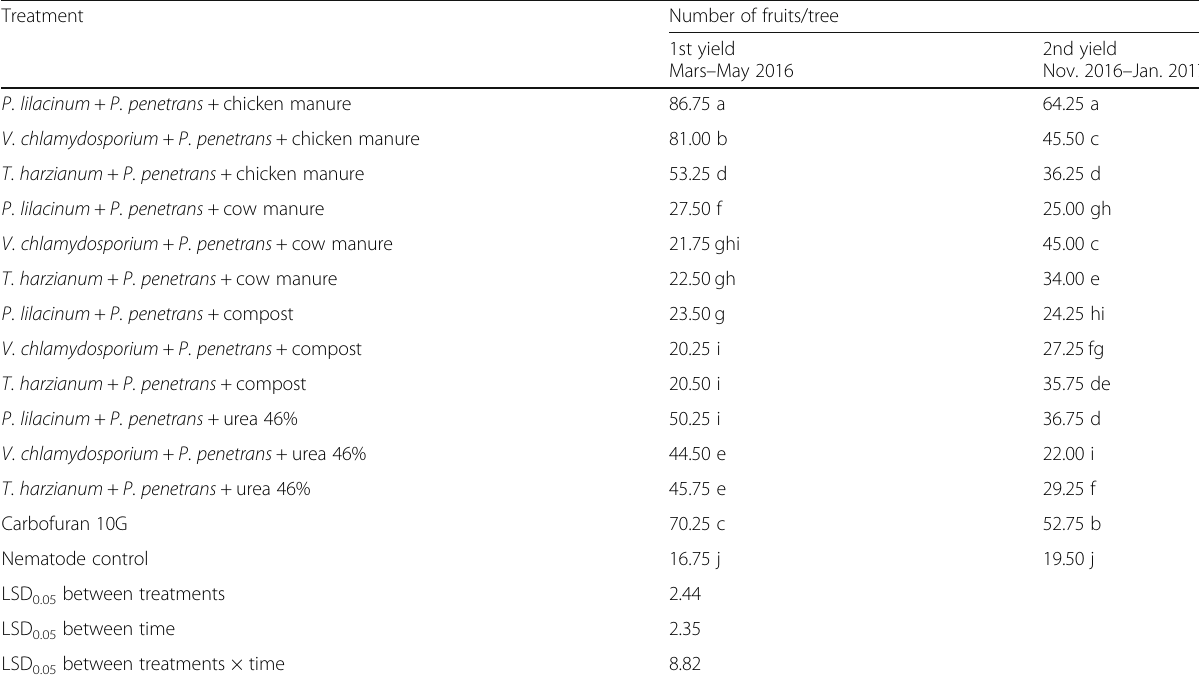
Table 4 Effect of different combinations of integrated control measures on the number of guava, Psidium guajava , fruits Treatment Number of